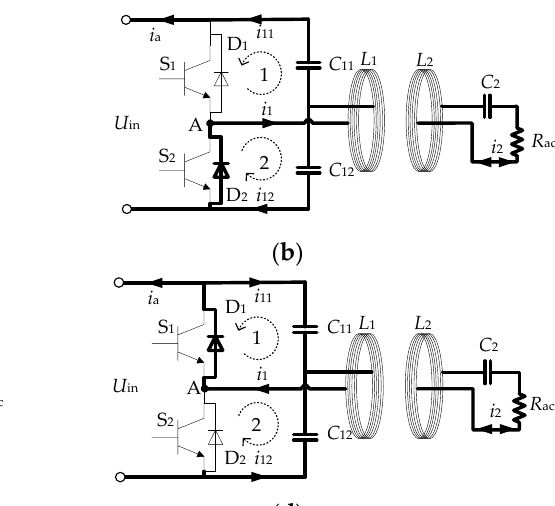
Figure 1. Comparison of the two topologies: ( a ) Proposed series-series/series (SS/S) symmetrical half-bridge resonant converter (SHRC)-based inductive power transfer (IPT) system; ( b ) The S/S full-bridge resonant converter (FRC) based system.